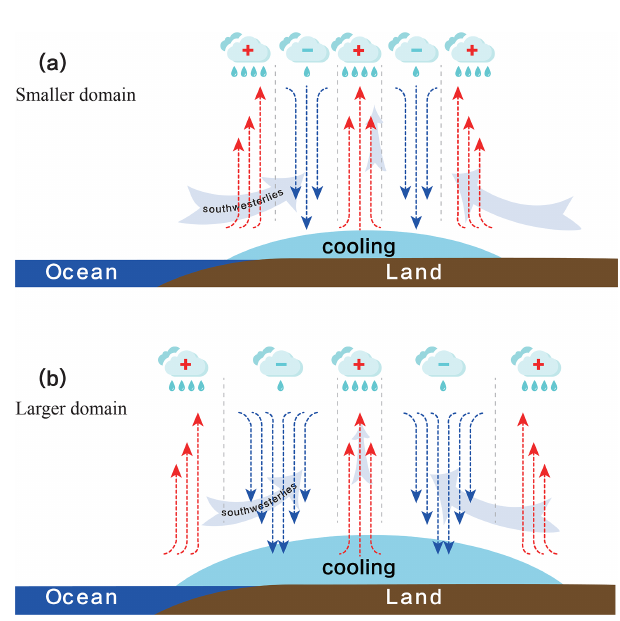
Figure 15. The schematic plot of aerosol impact in the (a) small- domain simulation and (b) large-domain simulation over East Asia. The light blue shadow area represents the extent of the aerosol- induced decrease in lower tropospheric temperature and increase in surface pressure. The red (blue) vector dash lines represent updraft (downdraft) anomalies. The “ + ” (“ − ”) above the region indicates the aerosol-induced increase (decrease) in